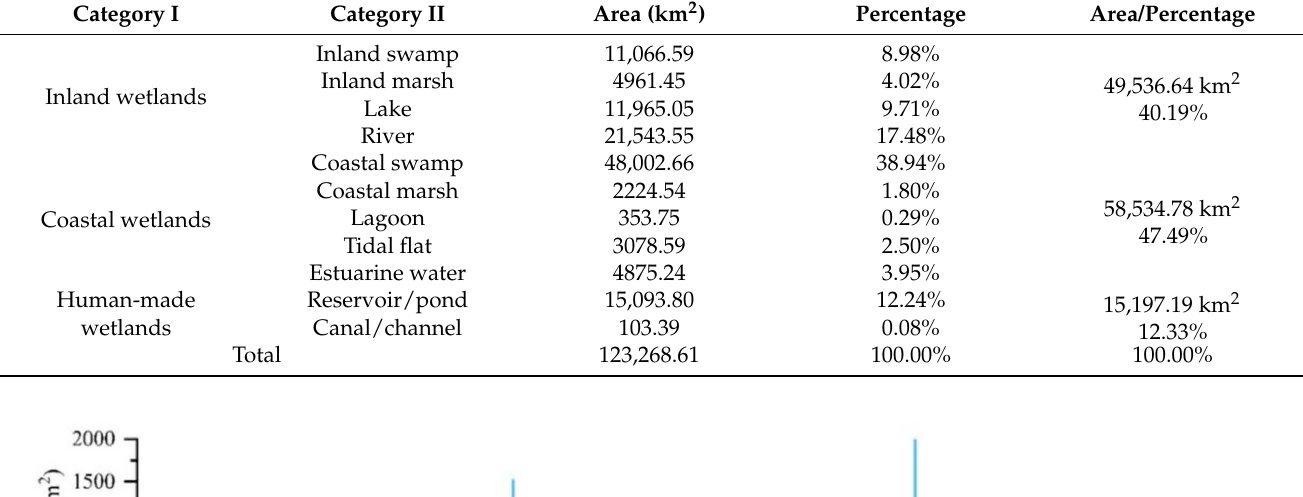
Table 4. The areas of the various wetland types in Southeast Asia Wetland Cover map.